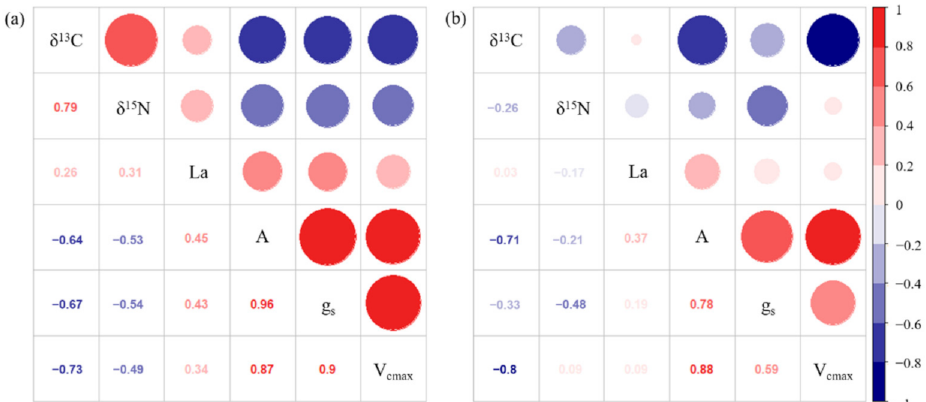
Figure 3. Pearson’s correlation matrix describing relationships among δ 13 C, δ 15 N, leaf area (La), CO 2 assimilation rate (A), stomatal conductance (g s ), and maximum RuBP-saturated rate of carboxylation (V cmax ) in durum wheat cultivars Claudio ( a ) and Mongibello ( b ) exposed to 0 or 80 ppb of ozone (5 h day − 1 ) at different growth stages (7, 28, 50, 70 days from the beginning of